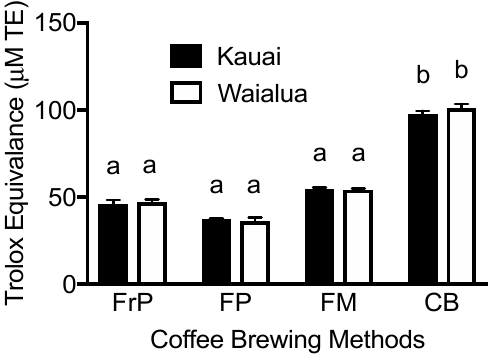
Figure 6. Antioxidant capacity of Kaua’i and Waialua coffee. FrP, French press; FP, filter paper; FM, filter mesh; CB, cold brew; K, Kailua; W, Waialua. Data are represented as mean ± SD (n = 18). a,b Mean values with common letters do not differ ( p < 0.05).